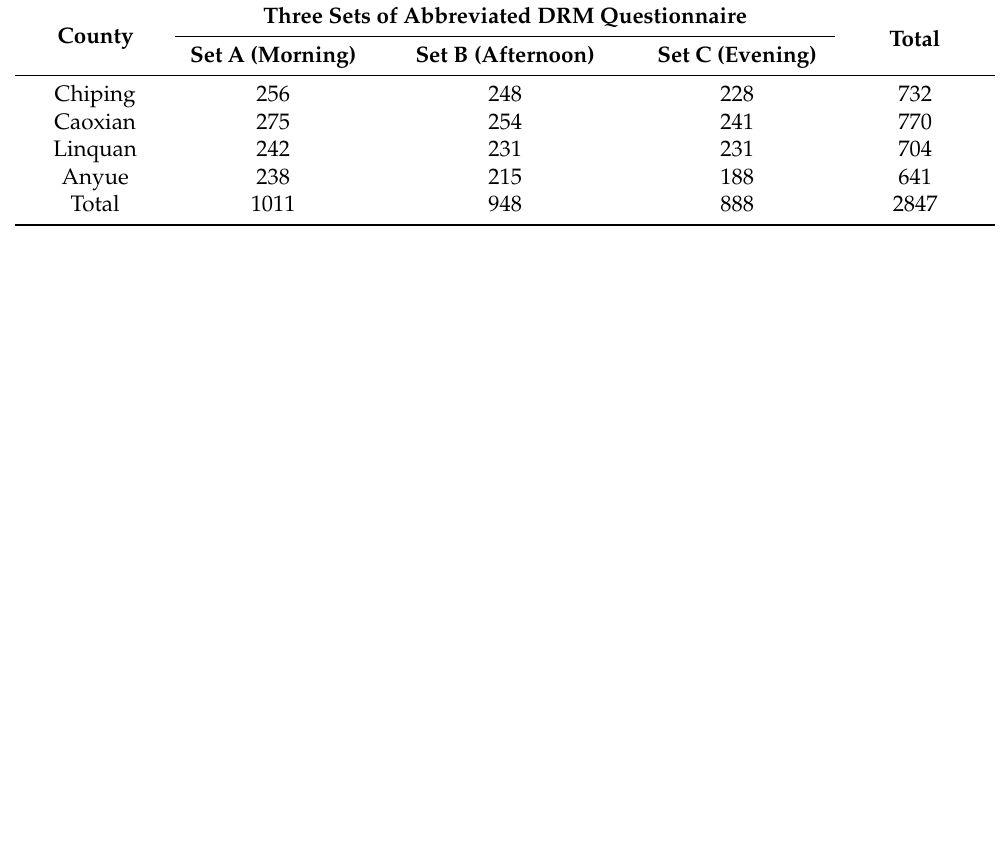
Table A2. The distribution of three sets of abbreviated Day Reconstruction Method (DRM) question- naire across